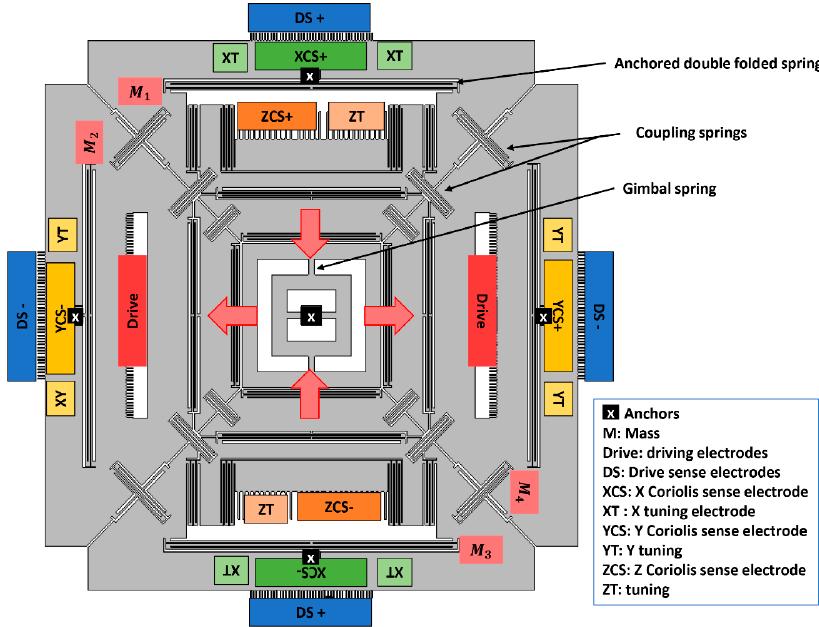
Figure 1. Schematic of the designed single drive multi ‐ axis gyroscope. Table 1. Design parameters of single drive multi ‐ axis gyroscope.